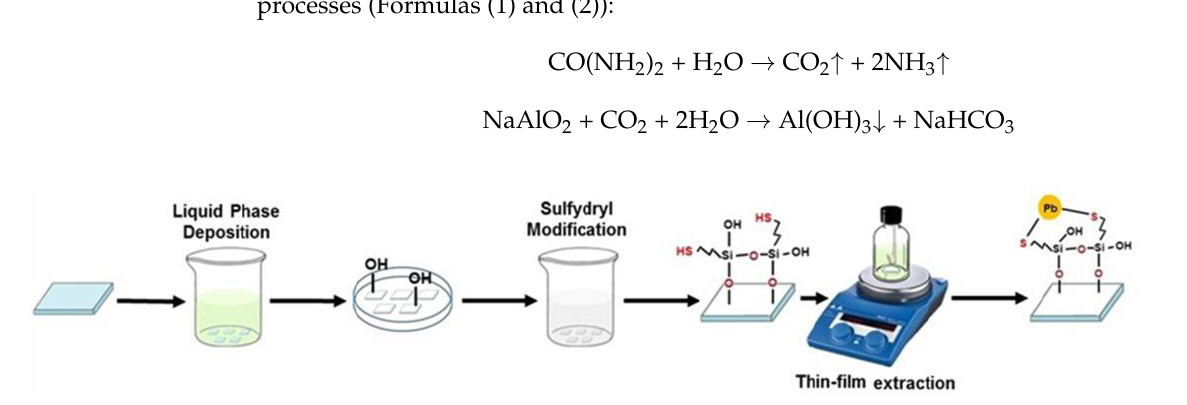
Figure 1. Schematic illustration of Al(OH) 3 -SH layer preparation and Pb 2+